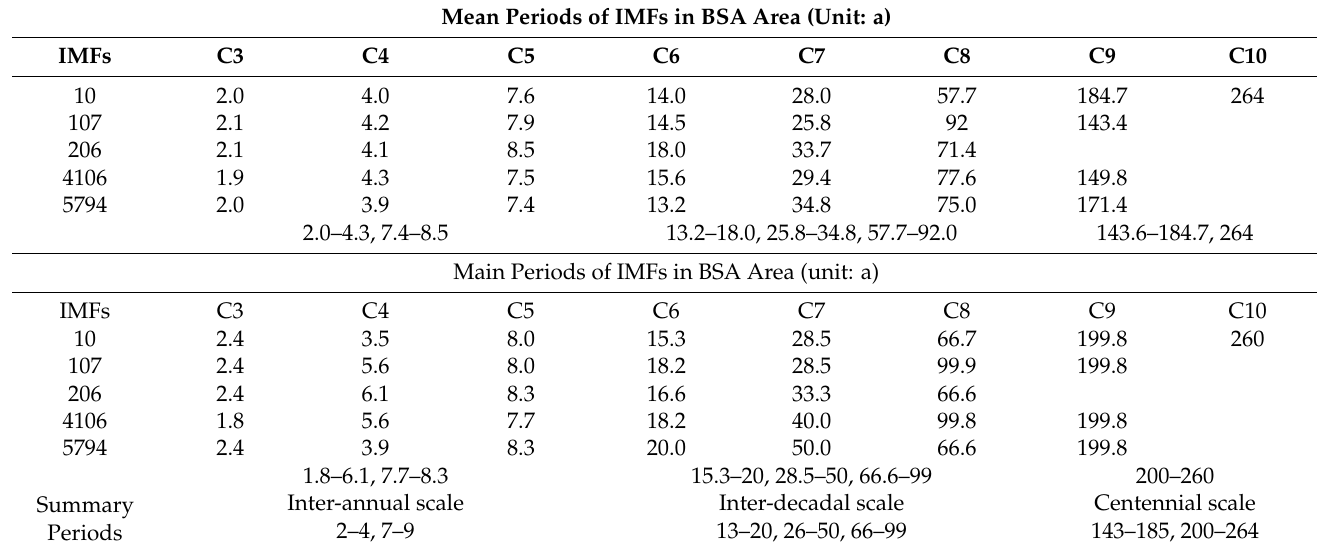
Table 4. Multi-scale periodic analysis of temperature in areas around the Baltic Sea area (BSA). Mean Periods of IMFs in BSA Area (Unit: